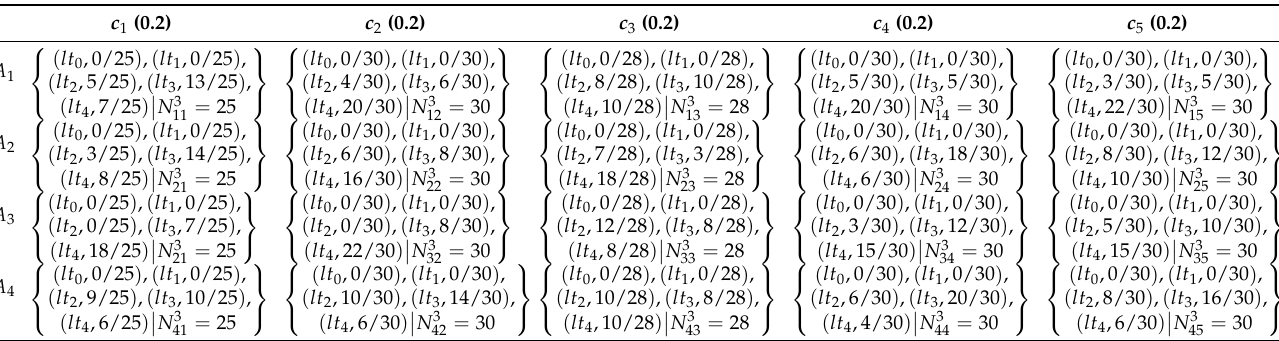
Table 3. LDAs decision matrix of d 3 .